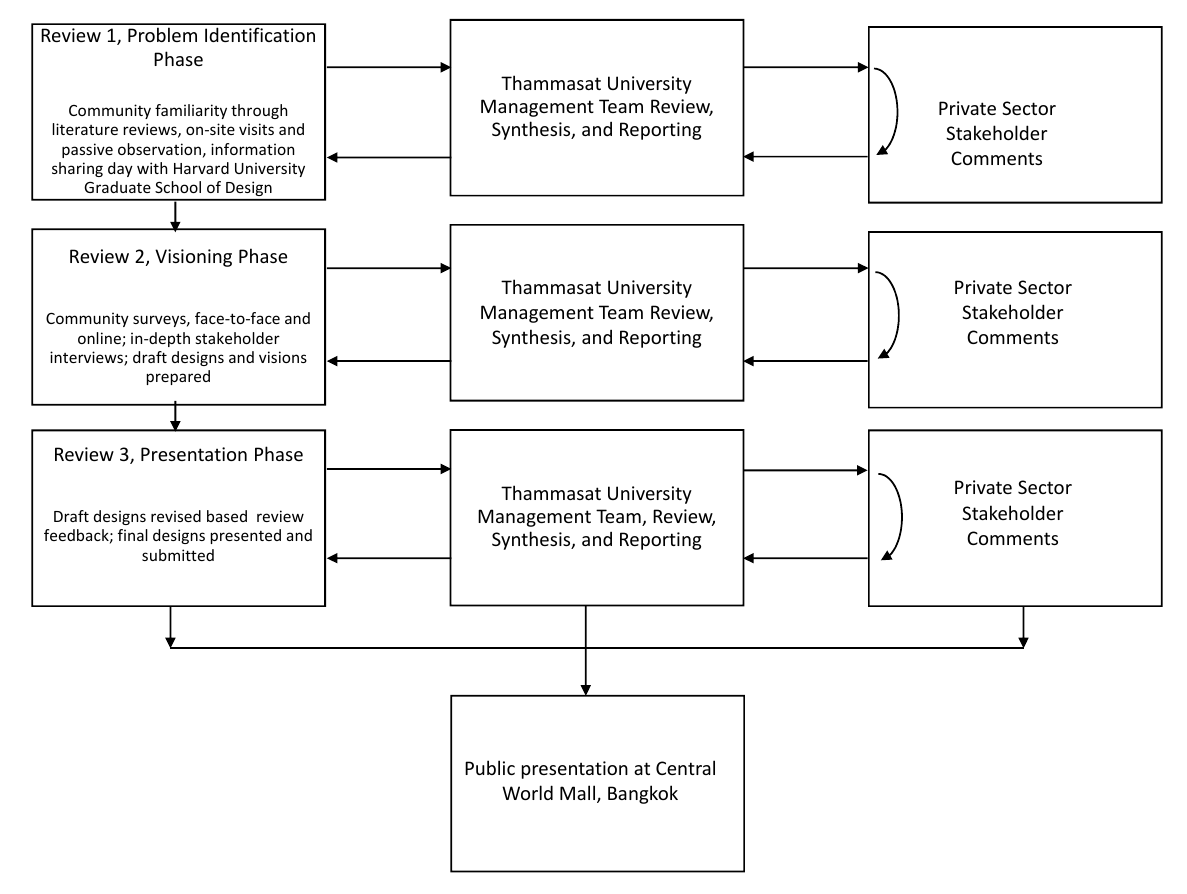
Figure 1. Research workflow for the